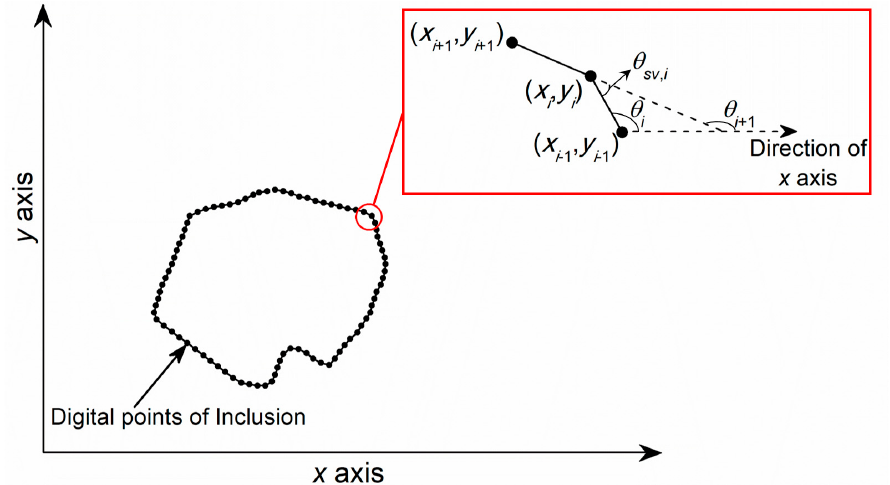
Figure 7. Schematic of the edge angle θ sv , i for inclusions.